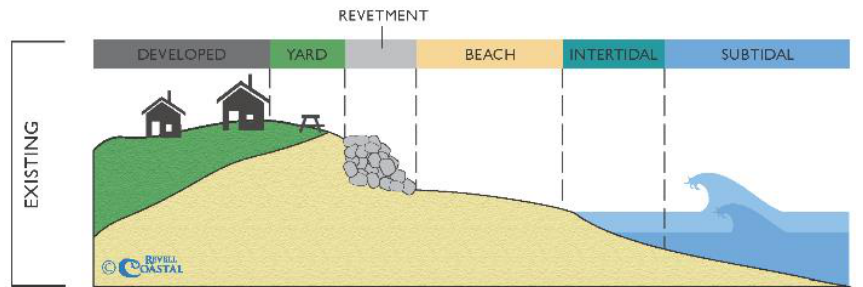
Figure 5. Conceptual model of physical upland and beach widths tracked as a result of adaptation strategy implementation over time. For this case study, developed and yard were considered as upland. The revetment in this figure was the adaptation project, while the beach, and intertidal were considered as the beach width.